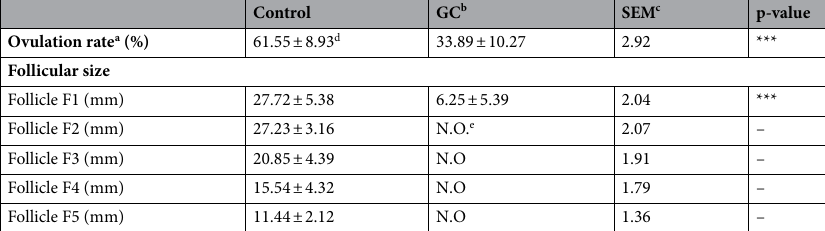
Table 1. The comparison of hen’s ovulation rate and follicular sizes F1 to F5 in control and GC groups (mean ± SD). Different statistical marks are significant (*P ≤ 0.05, **P ≤ 0.01, and ***P ≤ 0.001) according to the Dunnett’s test as a comparison procedure. a Laying frequency. b Glucocorticoid (Fluticasone, 2 ppm). c Standard error of the mean. d Standard deviation (SD). e Not